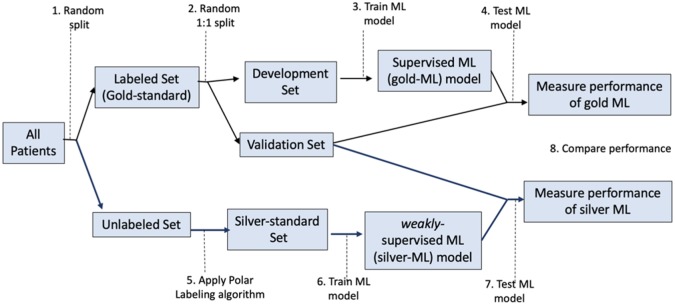
Experimental design